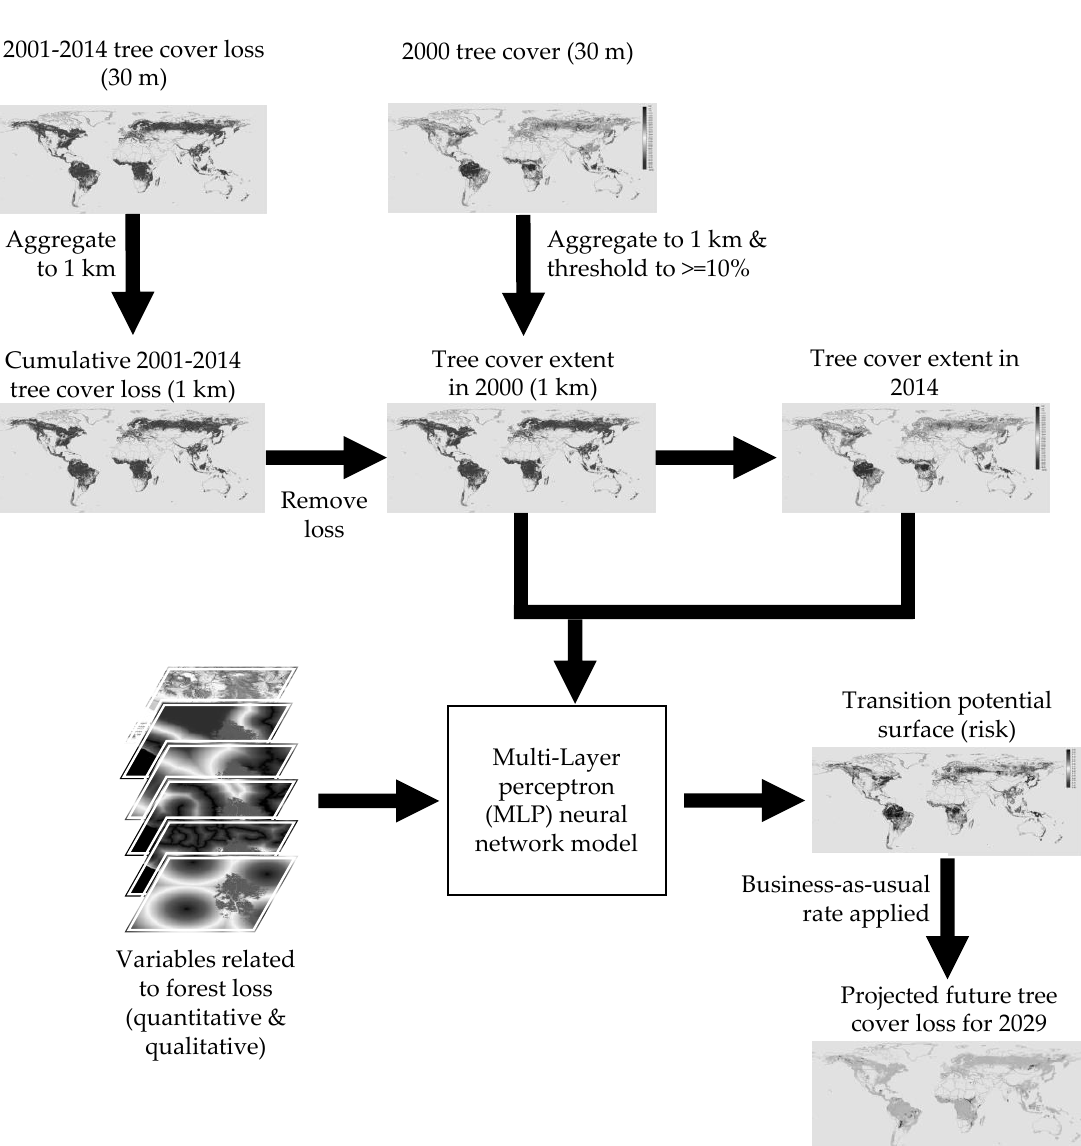
Figure 1. Flow diagram of the steps used to generate the transition potential surface and potential future tree cover loss for 2029 at the global scale. (A similar process was used for each of the six regional